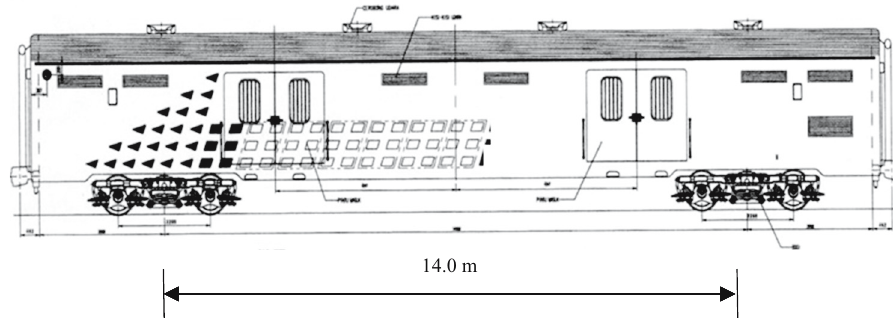
Figure 4: Distance between two single bogie in a passenger coach [ 32 ]